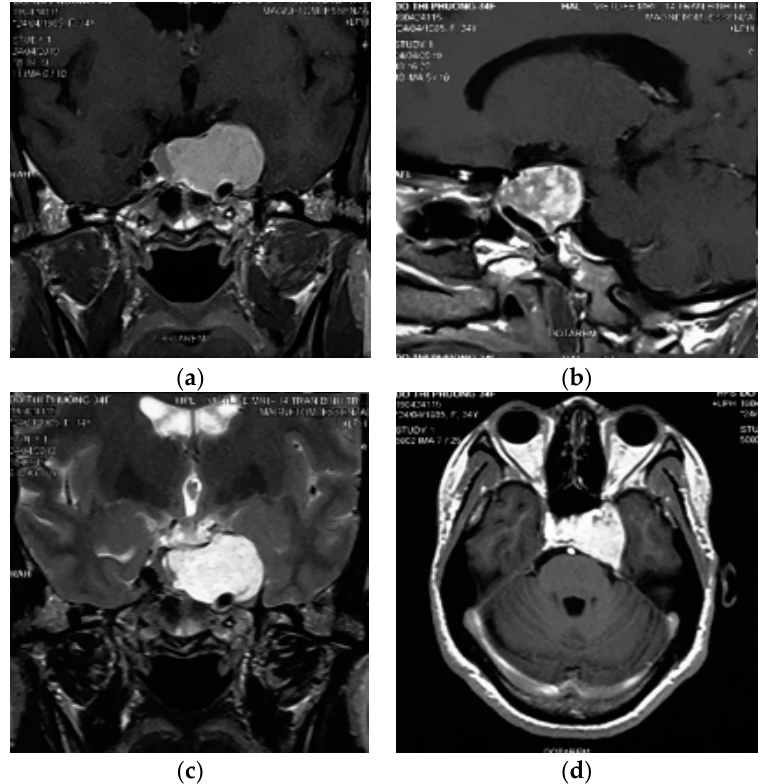
Figure 1. Contrast-enhanced magnetic resonance imaging examination of the brain. ( a , b ) Pre contrast coronal and sagital T1w showed an extra axial sellar and left parasellar mass with hyperintensity, the cavernous internal carotid artery is pushed inferiorly and encased by the lesion. ( c ) Coronal T2w showed a high signal intensity of the mass. ( d ) Initial gadolinium-enhanced axial T1w showed heterogenous enhancement of the mass.